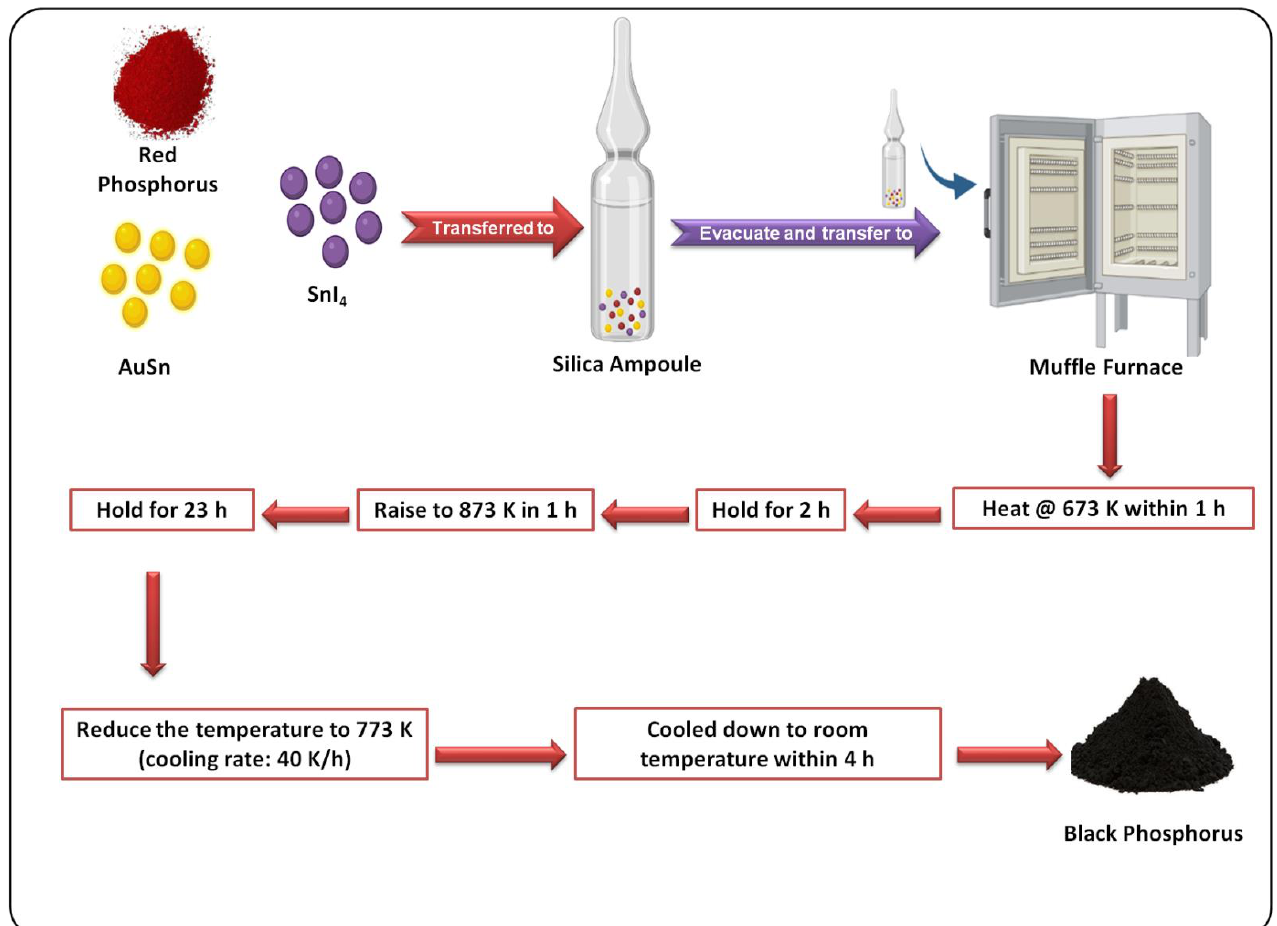
Figure 2. Facile synthesis method of black phosphorus.